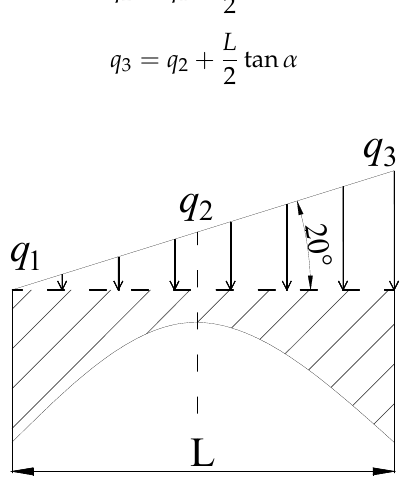
Figure 19. Structural model of force chain arch.